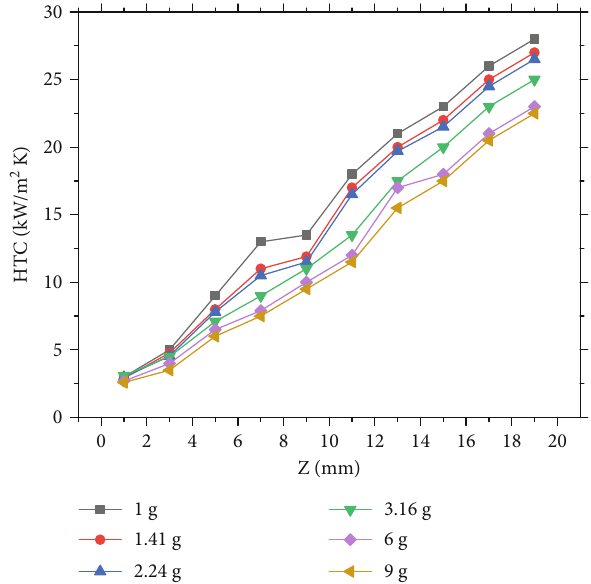
Figure 7: Heat transfer coe ffi cient of 0.02% nano fl uid under hypergravity.